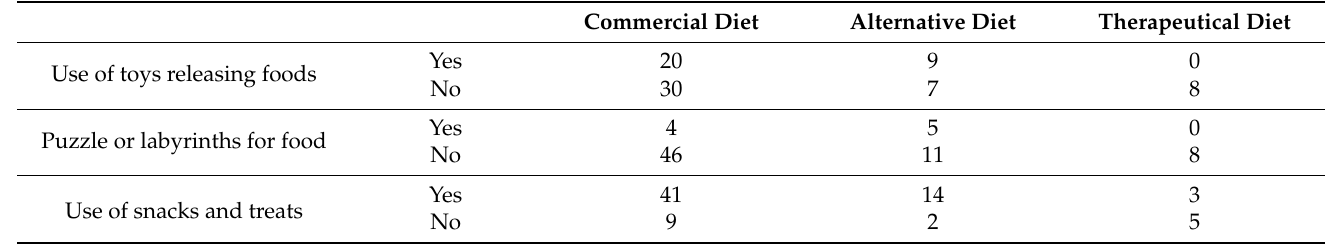
Table A5. Diet type and the use of toys releasing food, puzzles and labyrinths for food, and snacks and